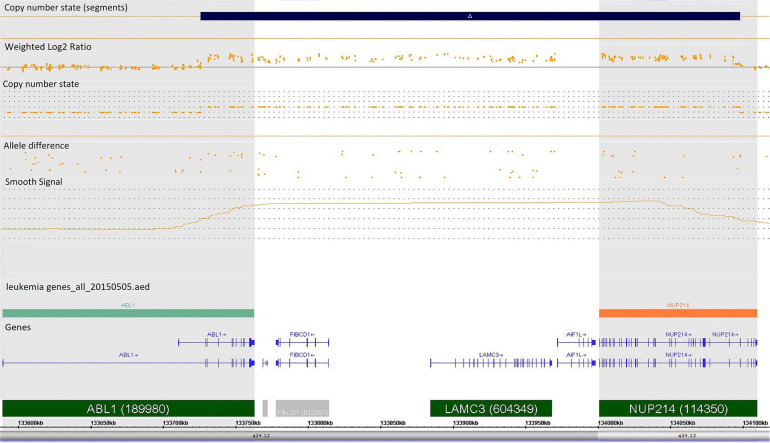
Single-nucleotide polymorphism (SNP) array of the amplification in 9q34 was limited by NUP214 (from exon 1 to exon 31) and ABL1 (from exon 2 to the 5′ end of the gene). Colored segmental region (top line: blue color—gains), copy number state allele difference, and smooth signal (bottom panel) aberrations by SNP array.